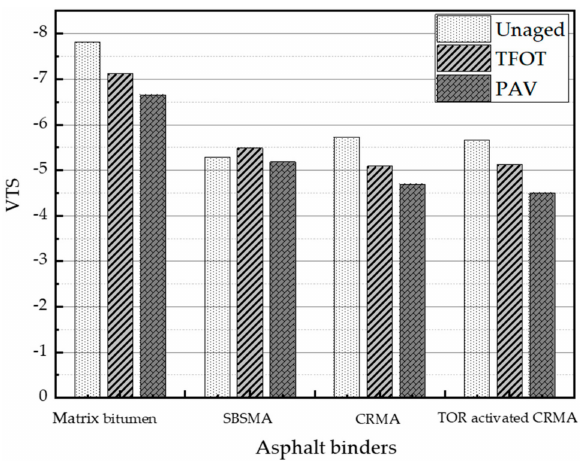
Figure 10. The viscosity temperature index (VTS) of four samples in di ff erent